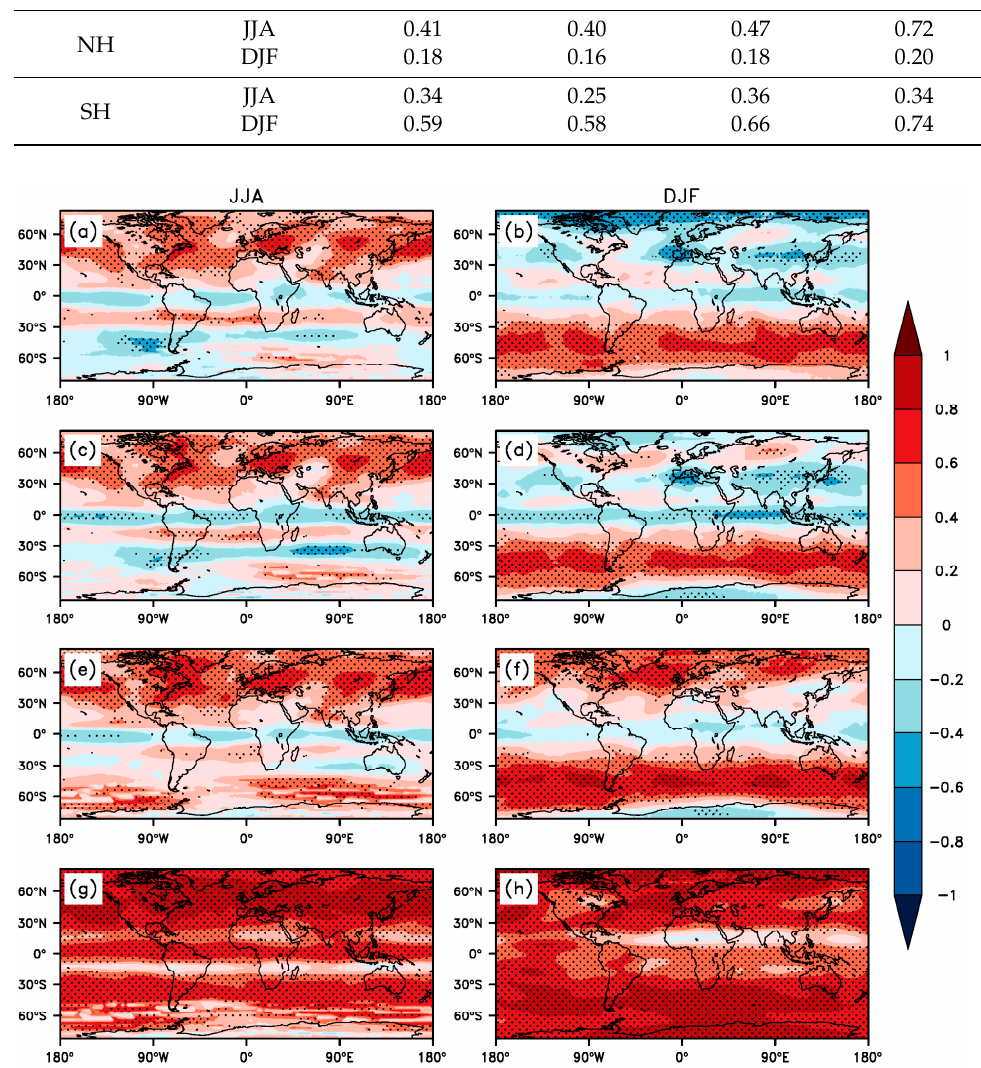
Figure 6. Geographic distributions of the correlation coefficients between stratospheric temperature and total column ozone over 1979–2020 in ( a , c , e , g ) JJA and ( b , d , f , h ) DJF in SSU channel ( a , b ) 3, ( c , d ) 2, ( e , f ) 1, and ( g , h ) TLS. Regions with dots are the places where correlation coefficients have statis ‐ tical significance levels higher than the 95% confidence